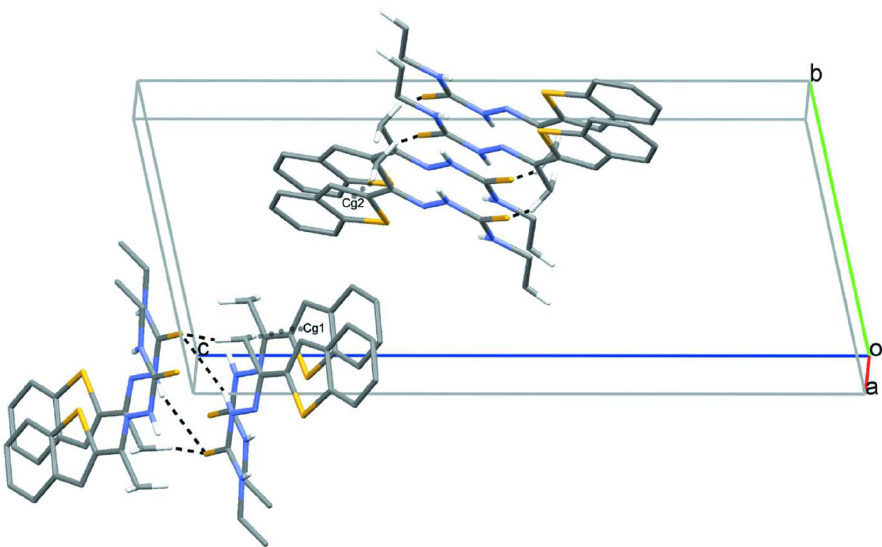
Figure 3 C—H··· π interactions between dimers in the title compound. Cg 1 is the centroid of the S1A/C1A/C2A/C3A/C8A ring and Cg 2 that of the S1B/C1B/C2B/C3B/C8B ring. H··· Cg interactions are drawn as dotted lines and hydrogen bonds as dashed lines. H atoms not involved in these interactions and atoms of one of the disorder components have been omitted for